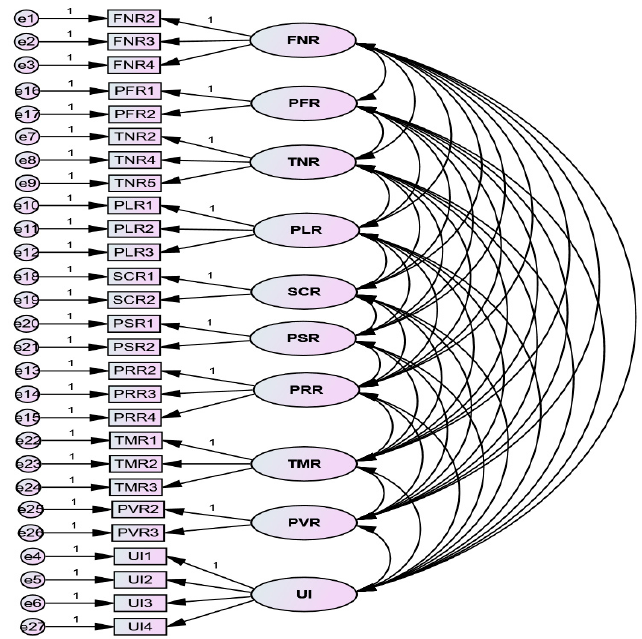
Figure 2. CFA for the measurement model.